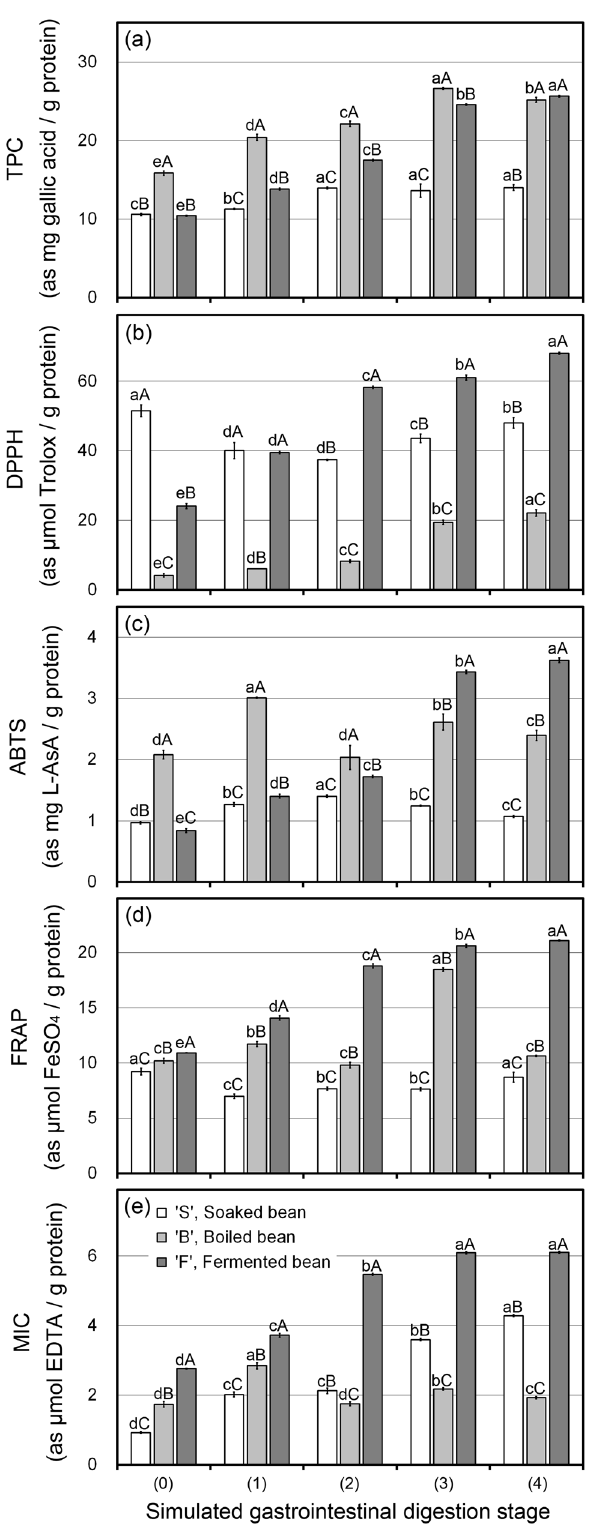
Figure 3. Changes in total phenolic content (TPC) ( a ), 2,2-diphenyl-1-picrylhydrazyl, 2, 2 ′ radical scavenging activity (DPPH) ( b ), 2-2 ′ azinobis-(3-ethylbenzothiazoline-6-sulfonic acid) radical scavenging activities (ABTS) ( c ), ferric reducing antioxidant power (FRAP) ( d ), and chelating metal ion activity (MIC) ( e ) of soaked (S), boiled (B), and fermented (F) soybeans at each digestion stage. Bars represent the standard deviation from triplicate determinations. Different lowercase and uppercase letters indicate significant differences ( P < 0.05) among digestion stages and among manufacturing steps,